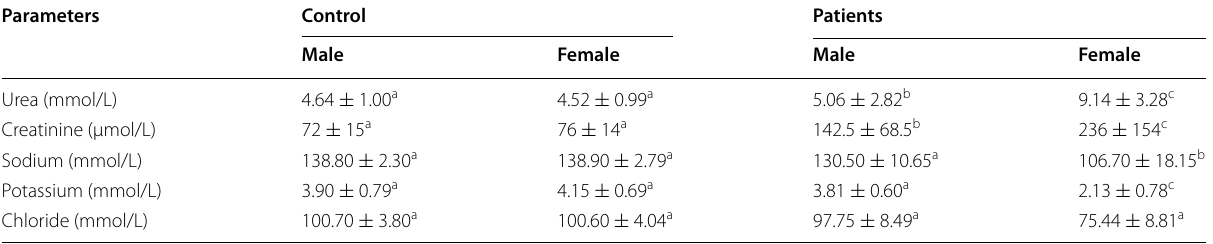
Table 5 renal function of patients with recurrent malaria cases in sir Yahaya memorial hospital Birnin Kebbi from 2016 to 2020